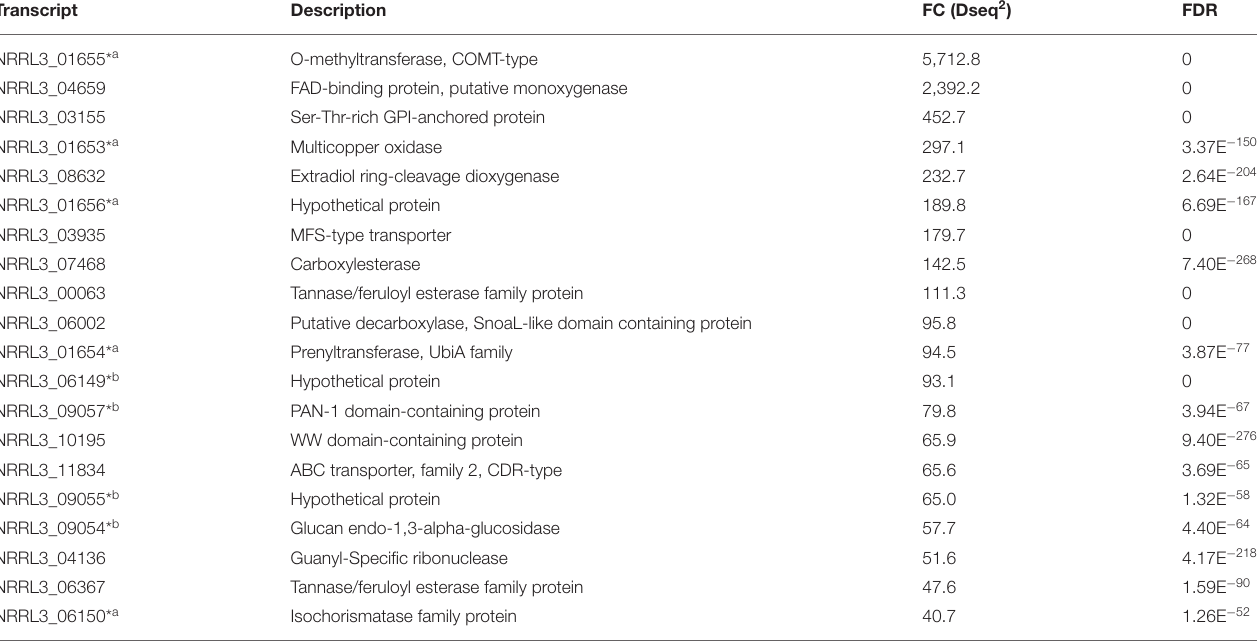
TABLE 2 | Top 20 of genes with the highest fold change (FC) in expression between the 1 tanX mutant and the parental strain during exponential growth on fructose.